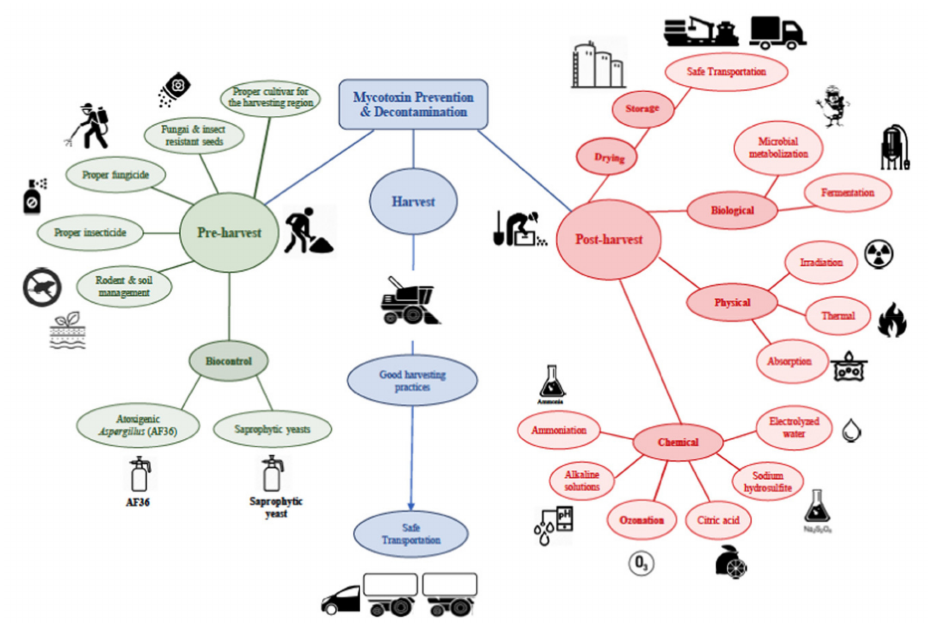
Figure 4. Schematic display of pre- and post-harvest tactics that can be applied to achieve mycotoxin prevention/detoxification, and their links to good harvesting practices and safe transportation (Reprinted/Adapted with permission from Afsah-Hejri, Hajeb, & Ehsani [211], 2020, John Wiley & Sons,